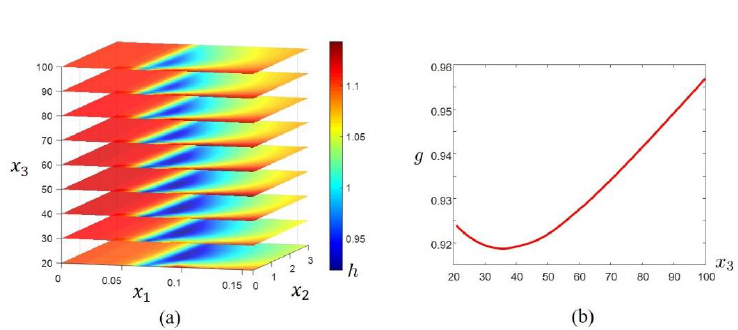
Figure 6. Cost function properties. ( a ) Variation in h for fixed x 3 ; ( b ) convexity of the parent function with respect to x 3 .